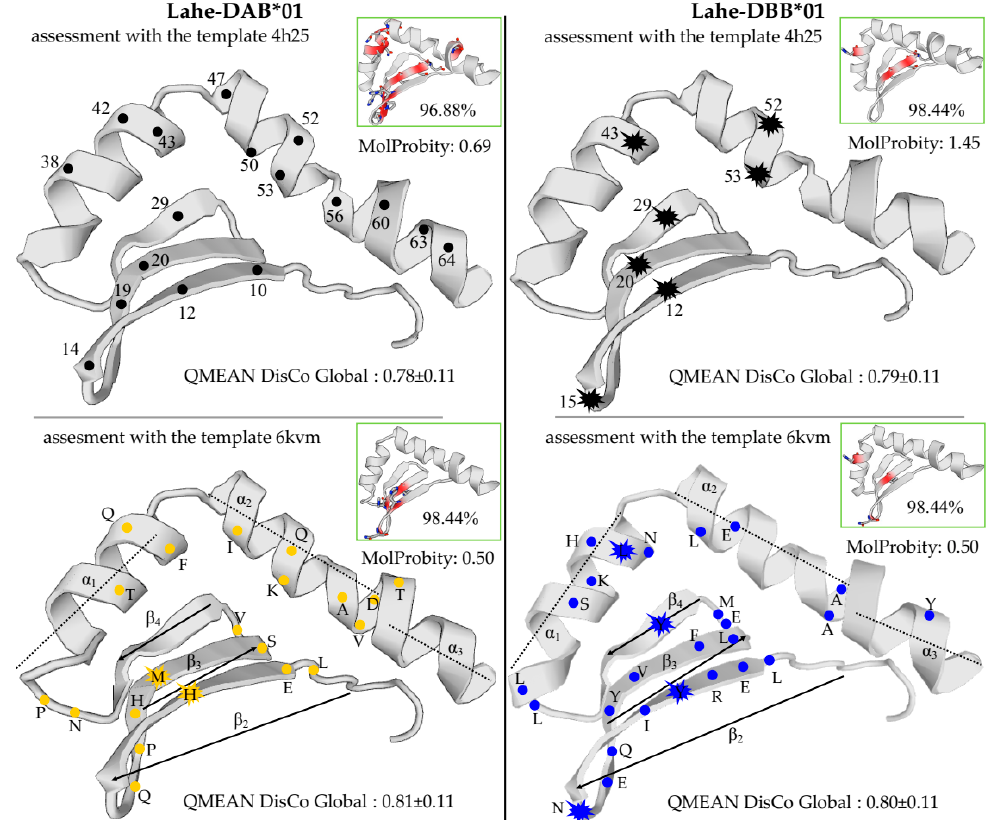
Figure 3. Modeling by homology for the two most common MHCIIB alleles in Heermann’s Gull (Lahe-DAB*01 and Lahe-DBB*01). The assessment lowest MolProbity scores and the highest QMEAN DisCo Global scores showed that the chicken template (6 kvm) had a better model quality than the human template (4h25). The Ramachandran-favored (%) and bad angles (in red) are shown within the green boxes. Black dots indicate the PBSs inferred from humans [46,47]. Black explosions indicate all the highly polymorphic sites inferred through Wu–Kabat variability (W). Both yellow and blue dots indicate variable sites and both yellow and blue dot explosions indicate the more polymorphic sites assessed for the DAB and DBB clusters by W variability.